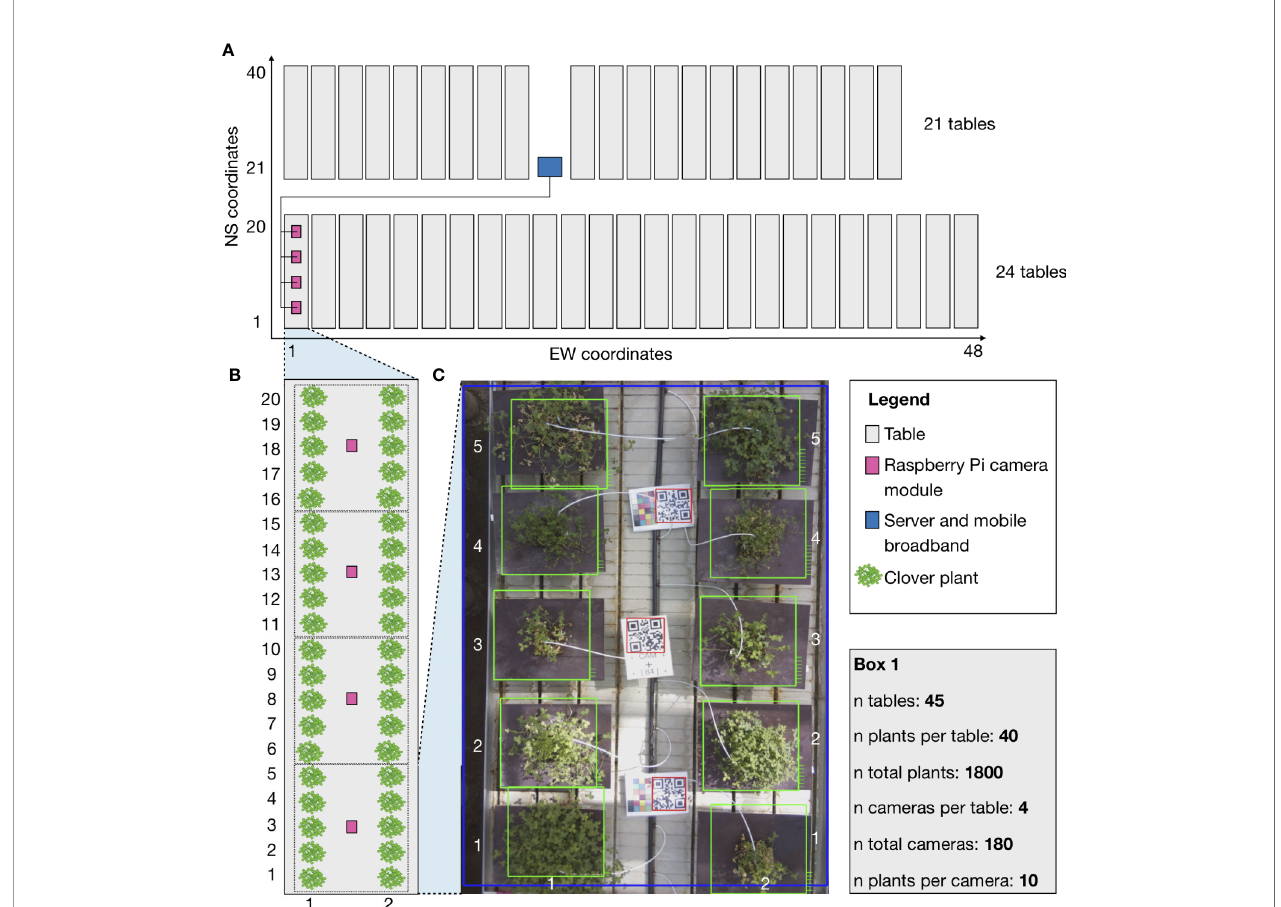
FIGURE 1 | Schematic showing the general setup of the phenotyping system and experimental setup. The schematic corresponds to the physical setup in the greenhouse. The grey boxes are moveable tables. The pink boxes are RPi camera modules fi xed (2 m) over the tables in a fi xed position. The blue box indicates the location of the central computer, which all of the camera modules were connected to. Green indicates locations of clover plants that were studied in the experiment. The camera modules are only shown for a single table, but camera modules were mounted over all tables with four per table. (A) A full schematic layout of the greenhouse with relative table placements. EW (East-West) coordinates and NS (North-South) coordinates in the greenhouse describing the physical locations of each plant. (B) Close-up schematic of a single table with the division of clover plants for the cameras. (C) A further close up of a picture from a camera. EW coordinates and NS coordinates for the individual pots used to identify the placement of each plant. Box (1) includes the raw number of tables, plants, and cameras, describing the full